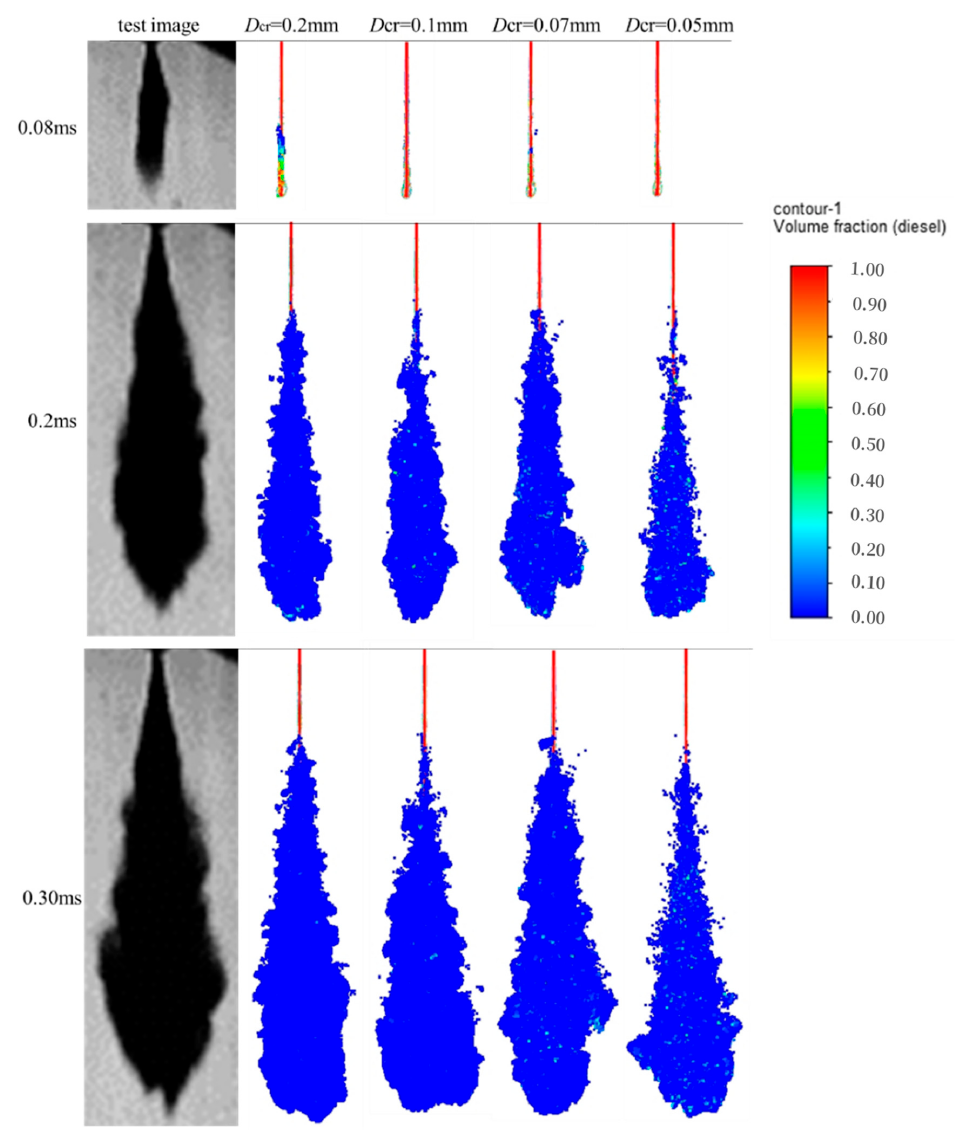
Figure 10. Spray cone profile.